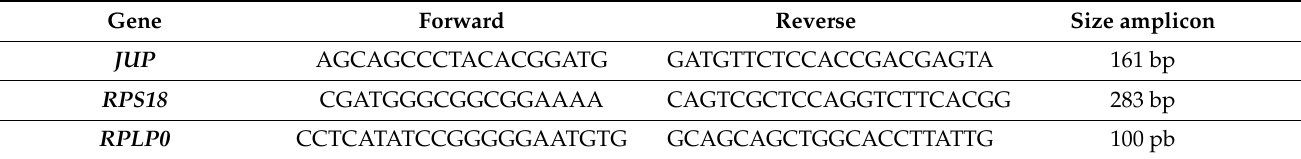
Table 1. Primer sequences used to evaluate JUP expression by